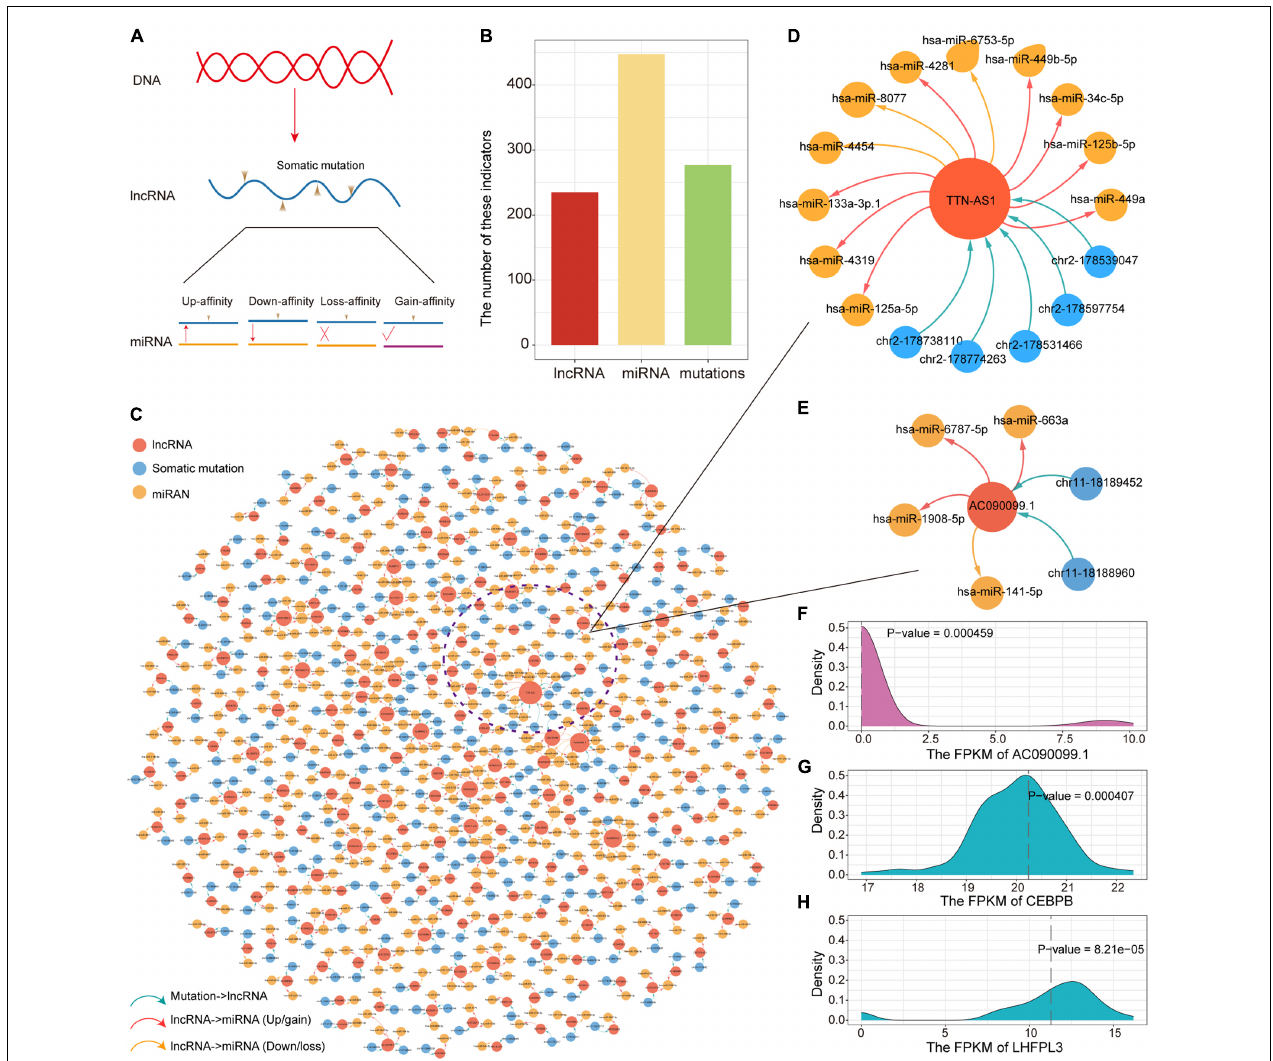
FIGURE 4 | Construction of the ceRNA dysregulated network. (A) Mutations in lncRNA affect binding intimacy with miRNA. (B) The number of lncRNA, miRNA and somatic mutations in the ceRNA dysregulated network. (C) The ceRNA dysregulated network constructed by lncRNA, miRNA, and somatic mutations. The red, blue and yellow nodes represent lncRNA, somatic mutation and miRNA, respectively. Up-regulated or newly gain affinity between miRNA and lncRNA used red line. Down-regulated or loss affinity between miRNA and lncRNA used yellow line. (D) The ceRNA dysregulated sub-network of lncRNA TTN-AS1. (E) The ceRNA dysregulated sub-network of lncRNA AC090099.1. (F–H) The distribution of the expression for lncRNA AC090099.1, CEBPB, and LHFPL3 was shown by density curve. The expression value of these genes in the mutant sample were marked with a red line. One-sample t -test was used to calculate statistical